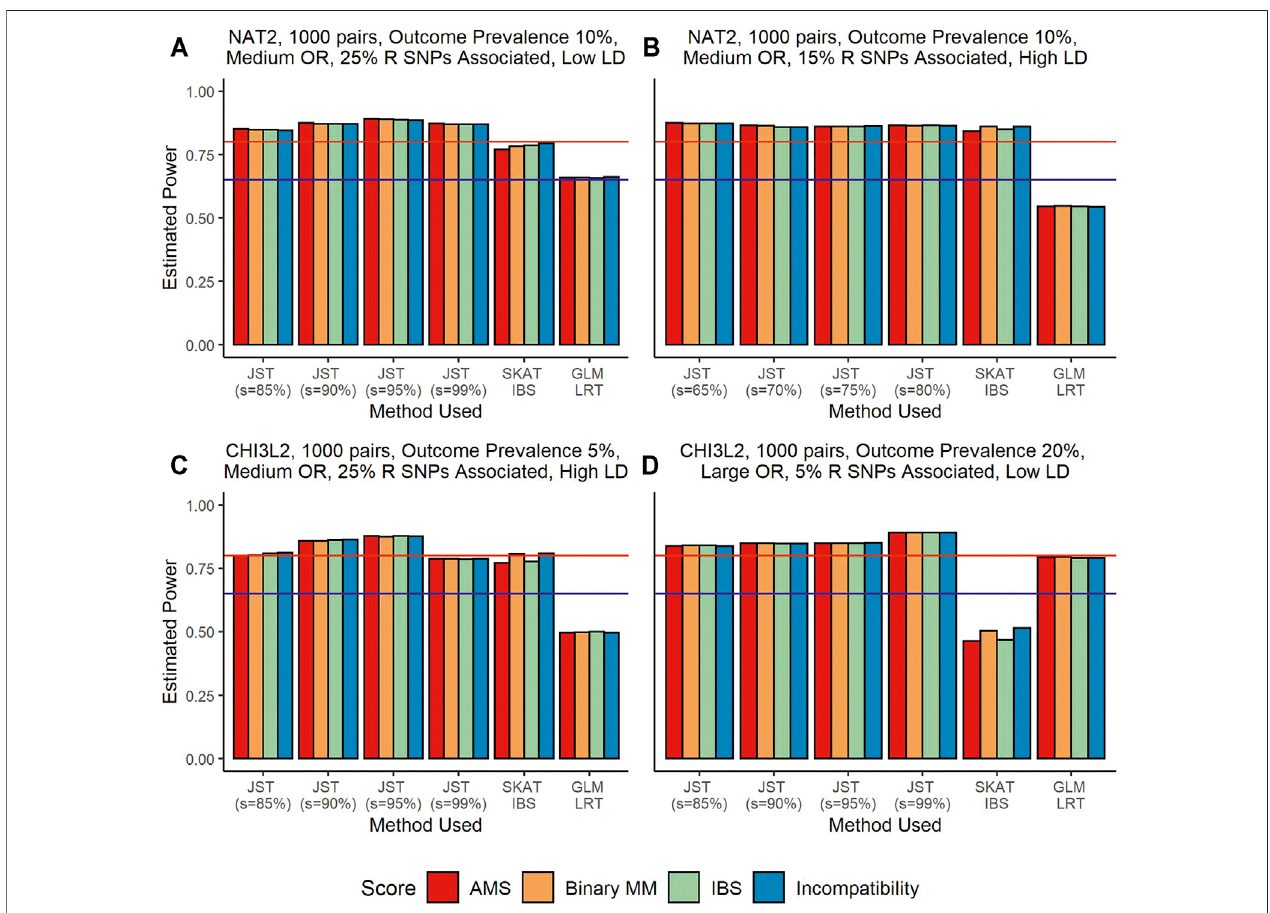
FIGURE1| Powerestimatesfromsimulationsusingthegenes NAT2 (Panels (A,B) )and CHI3L2 (Panels (C,D) )with1,000pairs ofdonorsand recipientsunderthe scenario that recipient genotype SNPs were associated with outcome. Panels (A,B) show an outcome prevalence of 10%. Panel (C) has an outcome prevalence of 5% and Panel (D) , 20%. Panels (A – C) show results for a medium OR (1.25) and Panel (D) for a large OR (2.00). Panels (A, C) show results when 25% of recipient SNPs are associated, while 15% areassociatedin Panel (B) and only 5%in Panel (D) .In panels (A, D) ,SNPs are inlowLDwhileinpanels (B,C) they areinhigh LD. Thefour colored bars represent which gene-based score was fi t in the model, with red corresponding to the allogenomics mismatch score (AMS), orange to binary mismatch score, green to identity-by-state (IBS) score, and blue to Incompatibility score. From left to right in panels (A, C,D) , the method used for model fi tting was the joint score test (JST), with s values of 85, 90, 95, and 99% of variance explained by the principal components (PCs), the sequence kernel association test (SKAT) with the unweighted IBS kernel, and a generalized linear model (GLM) likelihood ratio test (LRT). Panel (B) shows results for JST with s values of 65 – 80%. The y-axis shows estimated power from 0 to 100%. The horizontal blue line corresponds to 65% power and the horizontal red line corresponds to 80% power.